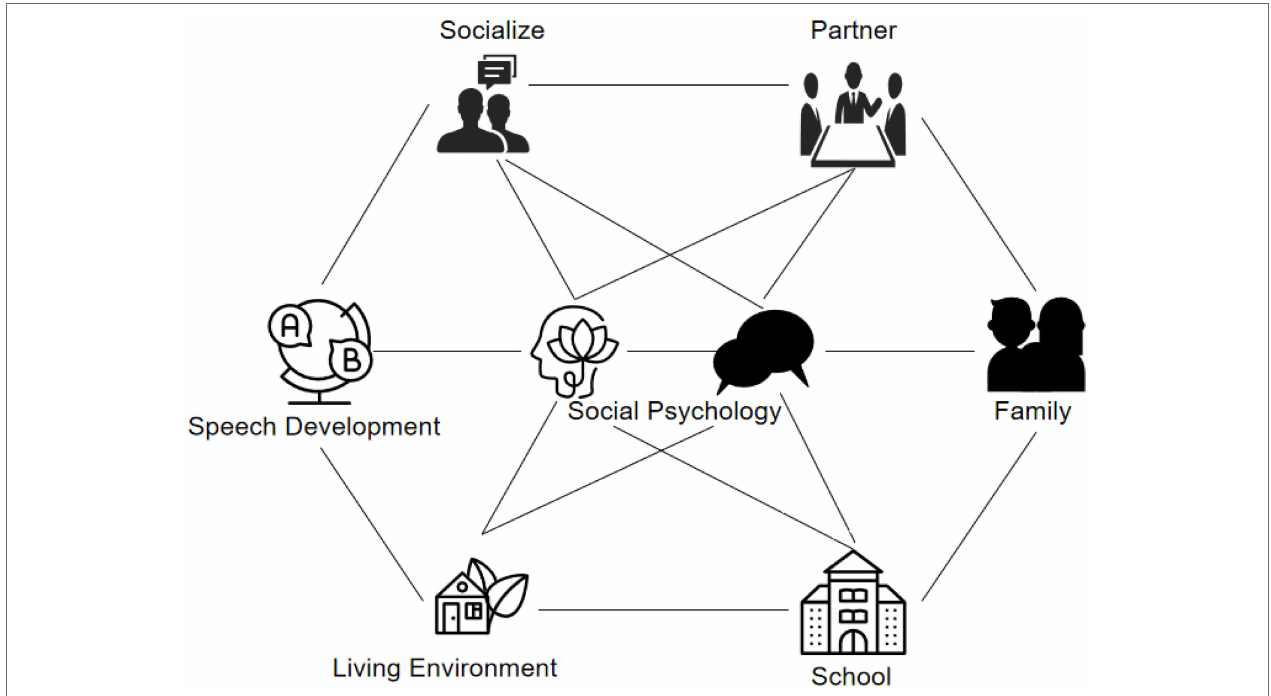
FIGURE 1 | Social psychology individual level research